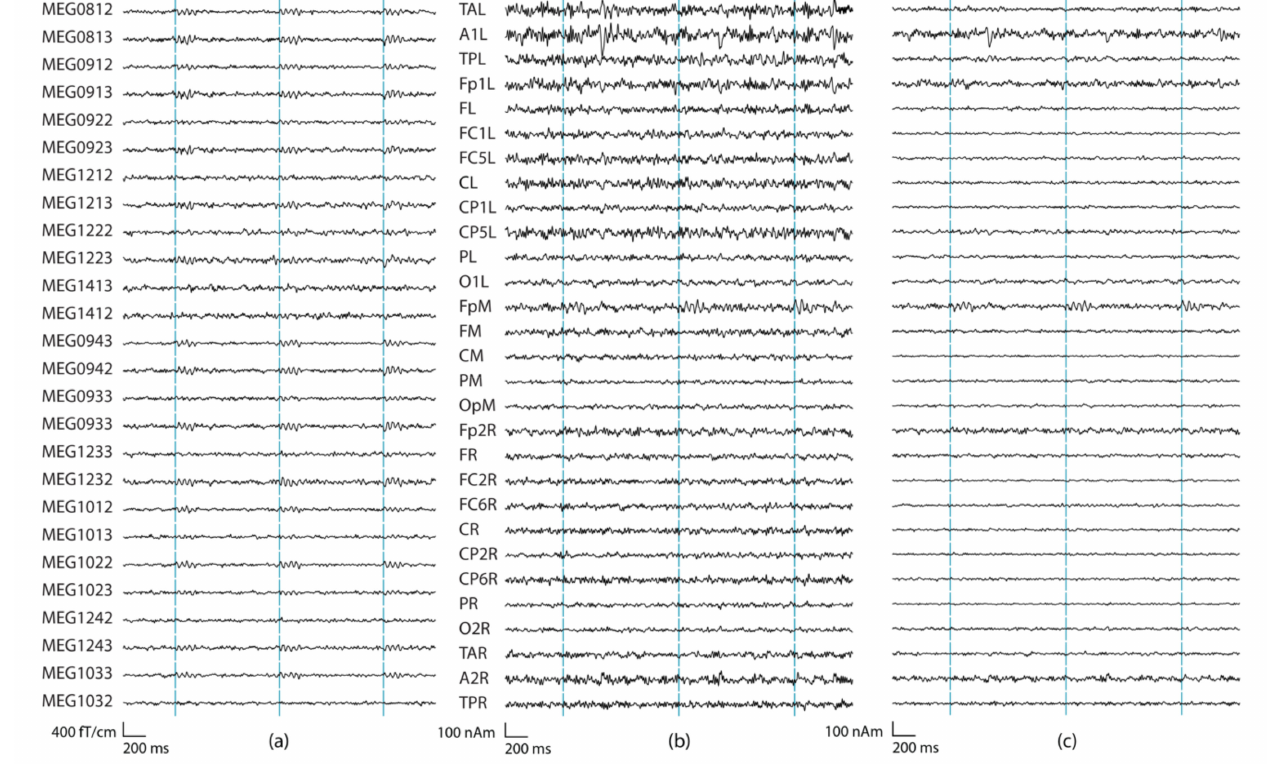
Figure 6. Examples of sensor-level and source-montage signals where the reconstructed activity is barely detectable. ( a ) Right frontal gradiometers. ( b ) BR29 montage waveforms with regularization 0%, ( c ) as in (b) but with 2% regularization. The source was a tangential frontal dipole with the amplitude of 100 nAm in a frontal location. Highest sensor SNR was 20 dB (MEG1022), and highest source montage SNR was 15 dB (FpM; distance to the nearest sensor is 74 mm, distance to the source montage channel with the highest SNR is 13 mm, Q = 35 nAm). In ( a ) Ndt1 = 20, in ( b ) Ndt = 0, and in ( c ) Ndt = 1.